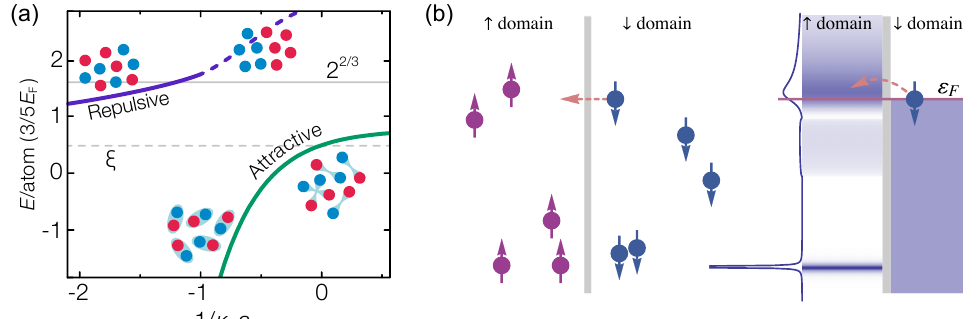
Figure 10. Ferromagnetic instability of a repulsive balanced Fermi mixture. ( a ) The energy of the upper (purple) and lower (green) many-body branches is illustrated, corresponding to a net repulsive and attractive interaction, respectively. The ground state is a paired phase, featuring a mean energy ξ E F at 1/ k F a = 0, where ξ ≈ 0.37 is the Bertsch parameter [129]. The repulsive per particle E = 3 5 Fermi liquid may undergo a ferromagnetic phase transition beyond a critical interaction strength along the upper branch, where a spin-segregated state is energetically favored. For an equal-mass, balanced mixture at T = 0, this occurs when the mean energy per particle of the mixed, paramagnetic E F , by a factor 2 2/3 . ( b ) Illustration of state exceeds that in a non-interacting Fermi gas, namely E = 3 5 the stability condition for spin-polarized domains. A spin- ↓ fermion can tunnel across a spin domain wall, thereby becoming a repulsive quasiparticle within the spin- ↑ domain. On the right, the energy levels available to the fermion are represented. If a well defined repulsive polaron exists and its energy overcomes the Fermi energy, i.e., E > E F , tunneling through the interface is suppressed and the domain wall is energetically stable. Panel ( b ) is adapted with permission from Ref.